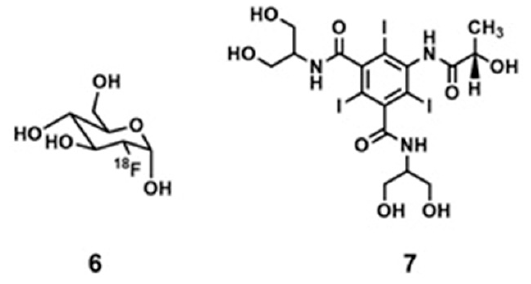
Figure 12. Chemical structures of 6 and 7 .